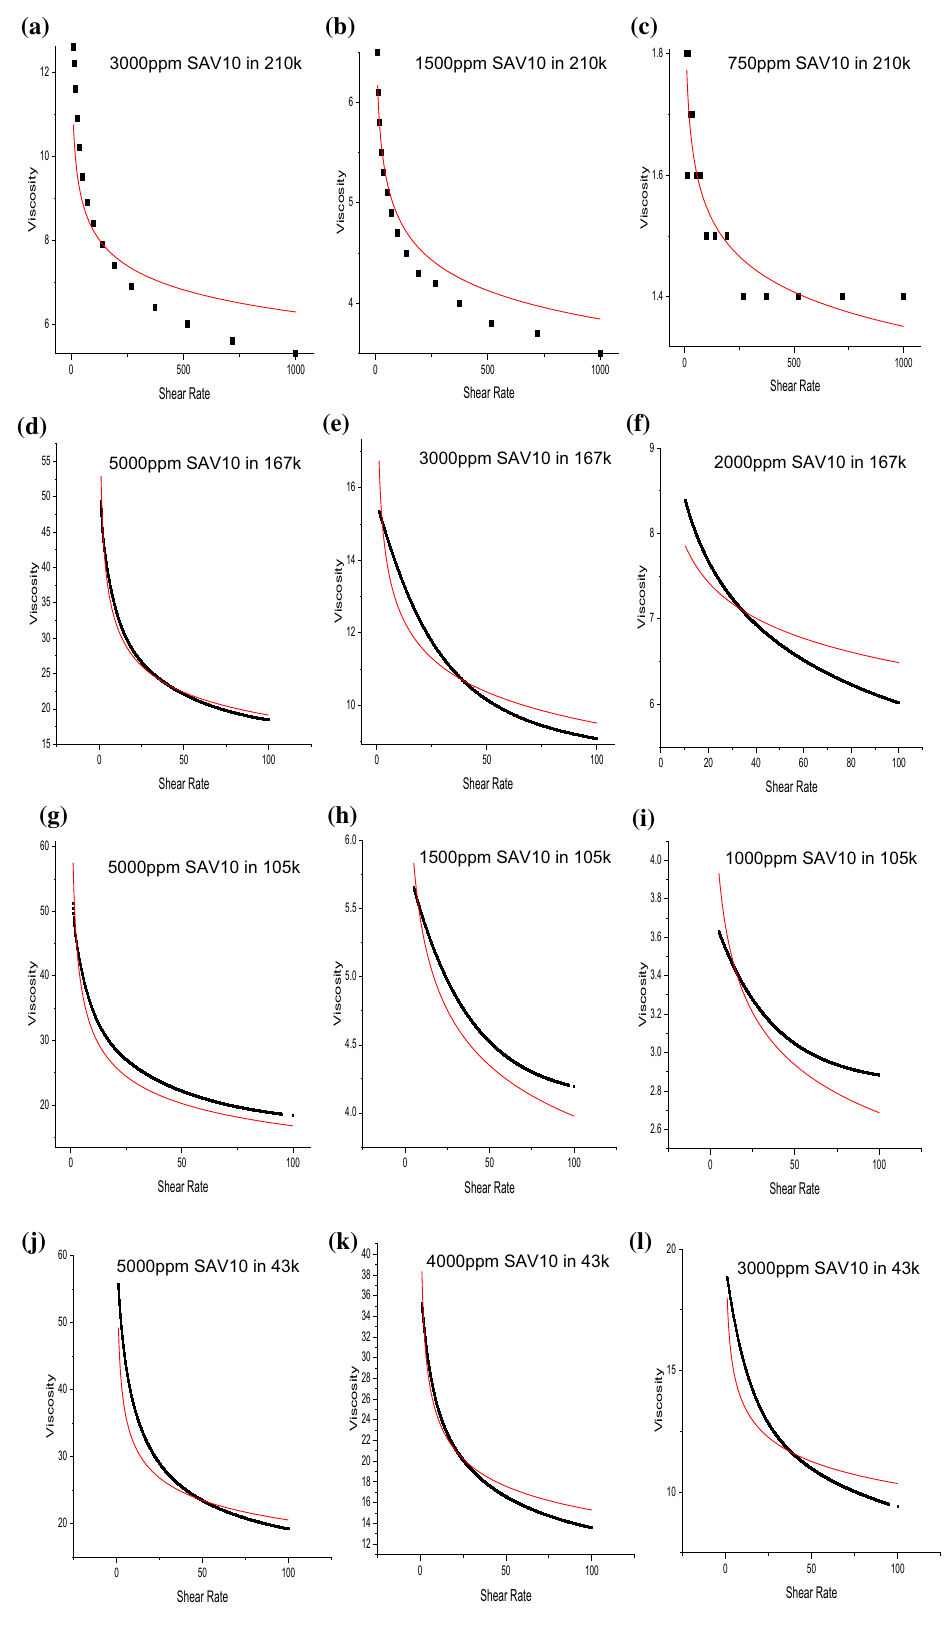
Fig. 16 Results obtained from Originpro non-linear regression